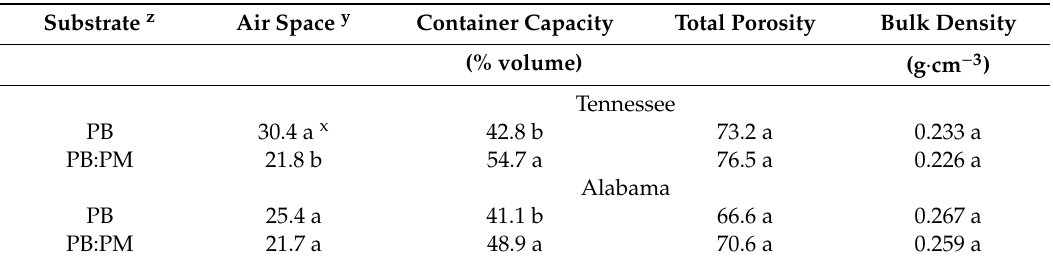
Table 3. Physical properties (n = 3) of substrates for production of ‘Green Giant’ arborvitae in Tennessee and